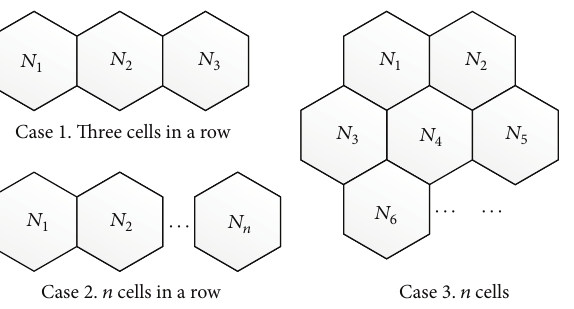
Figure 5: Network layout cases.